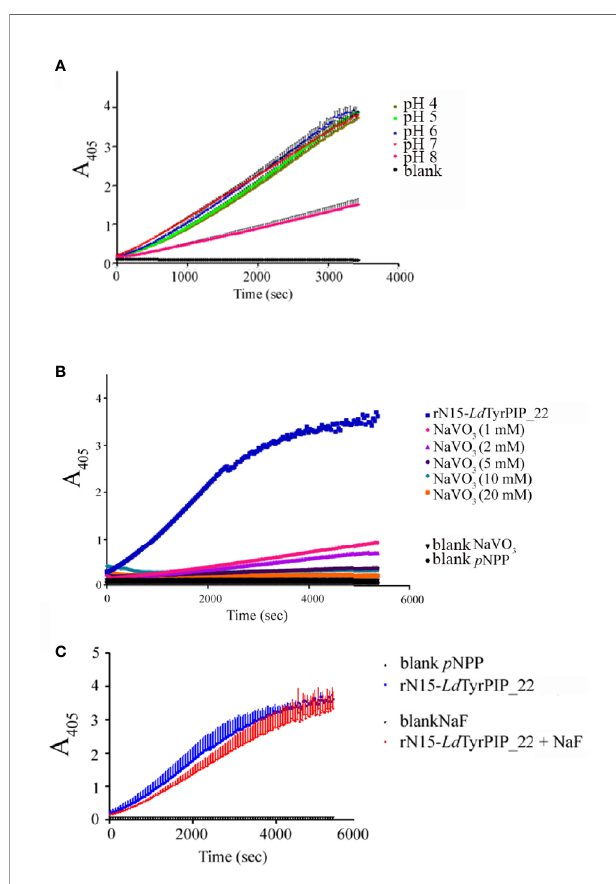
FIGURE 3 | Effect of pH and inhibitors in the rN15- Ld TyrPIP_22-His phosphatase activity. The rN15- Ld TyrPIP_22-His phosphatase activity was assayed at 25°C ( Materials and Methods ) with p NPP (10 mM) as substrate, (A) in pH ranging from 4-8; (B) in the presence of the speci fi c PTP inhibitor, Na 3 VO 4 (1 – 20 mM) or (C) in the presence of the speci fi c P-Ser/P-Thr phosphatase inhibitor, NaF (100 mM) at pH